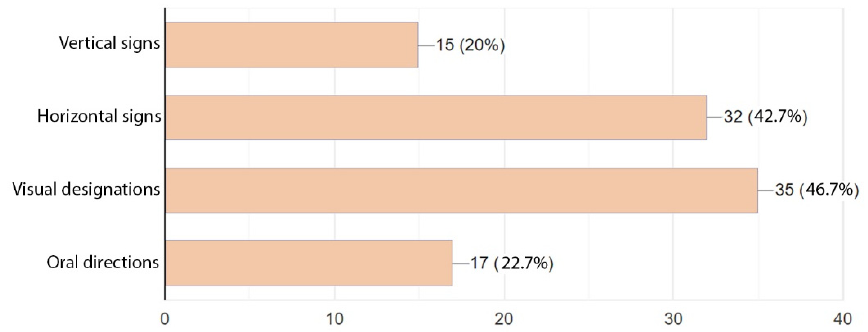
Figure 17. Preferences as to the visual identification system in a hospital—staff.